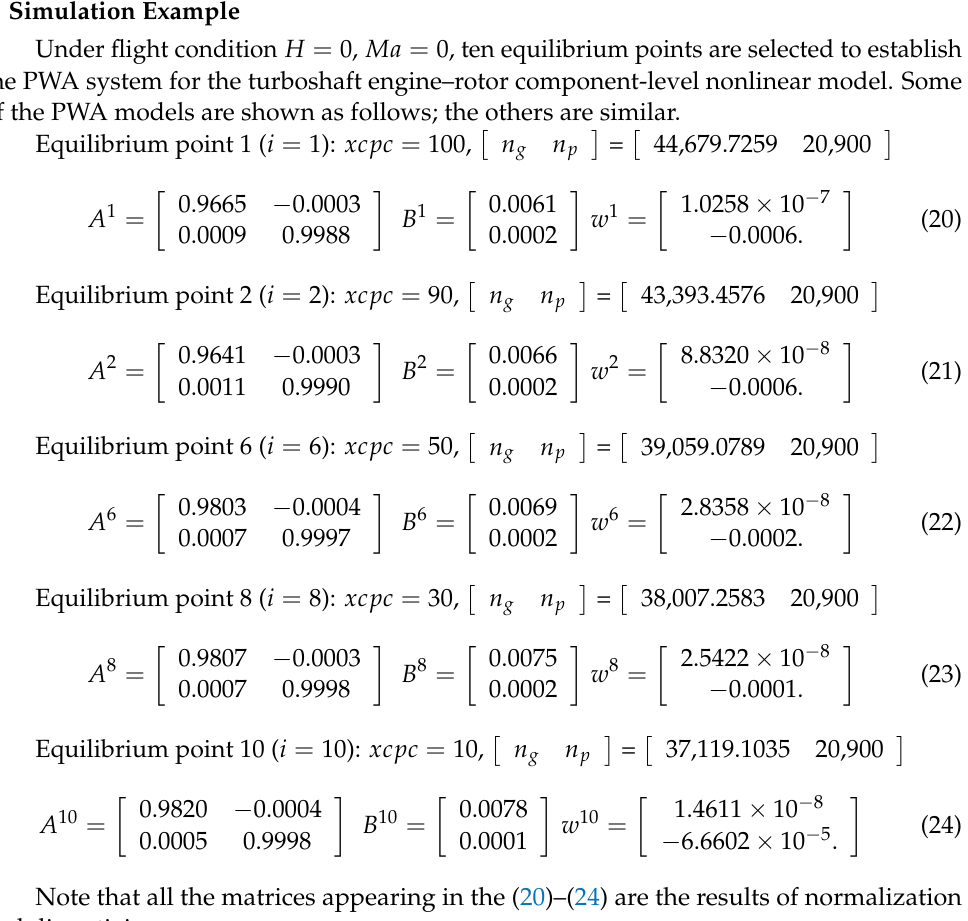
Figure 6. Affine function relationship between controller and state partition: N y =